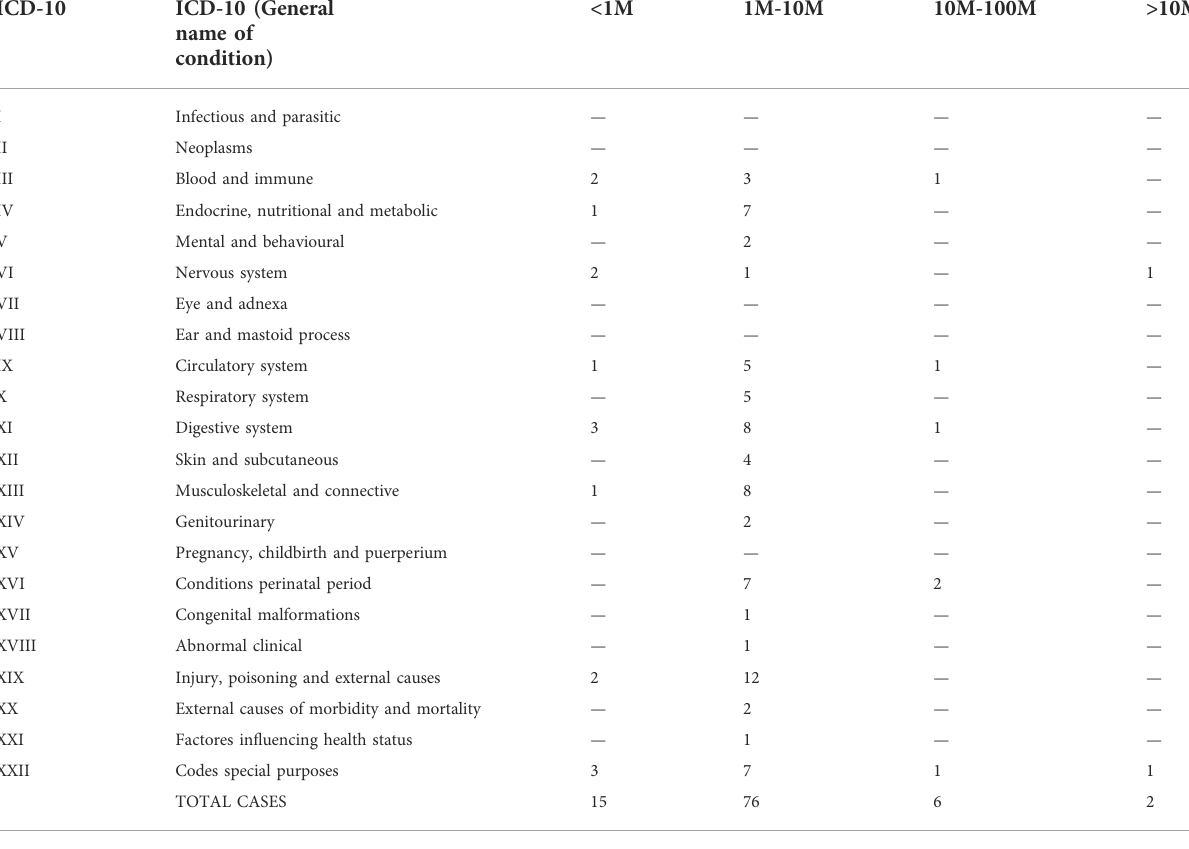
TABLE 7 Use of cell dose in different groups of medical conditions. The number of cells are referred to kg of BW of the patient.